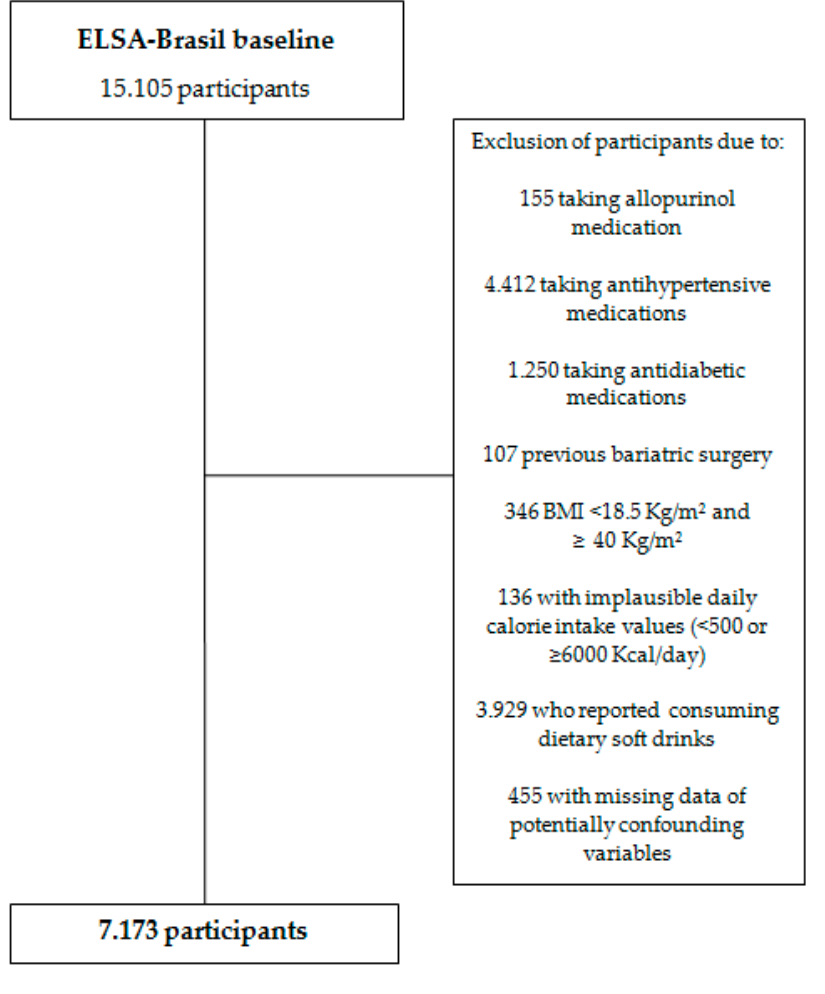
Figure 1. Exclusion flowchart for ELSA-Brasil participants.